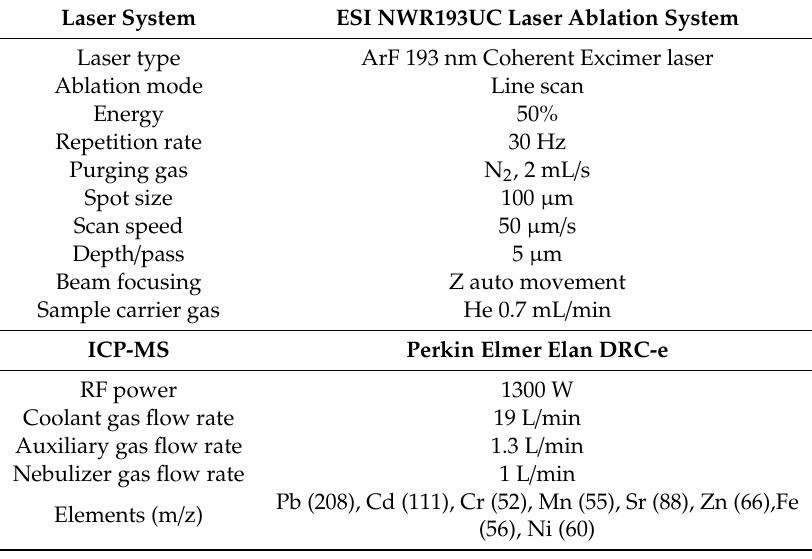
Table 2. Laser ablation inductively coupled plasma mass spectrometry (LA-ICP-MS) and ICP-optical emission spectrometry (OES) instrumental parameters and operating